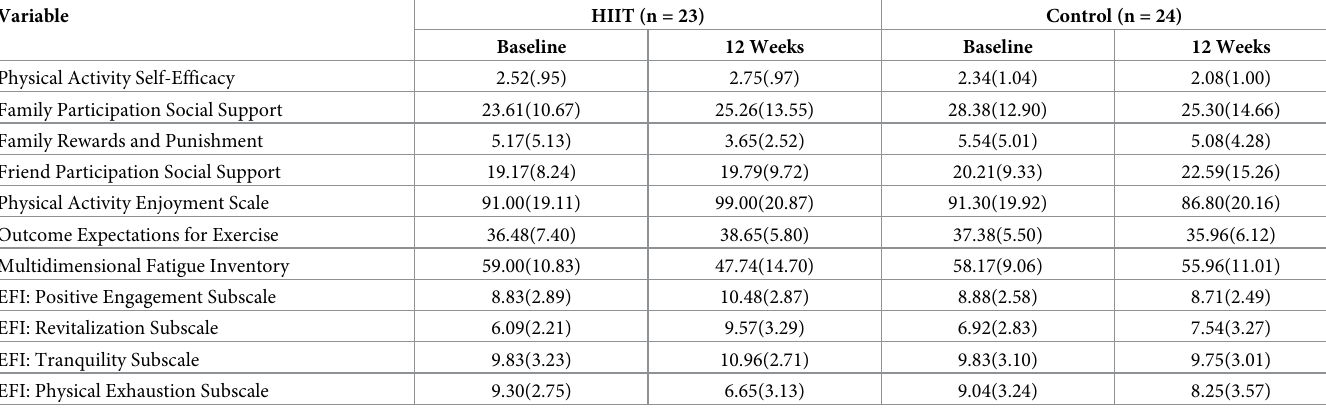
Table 5. The effect of HIIT on psychosocial variables: Unadjusted effects.